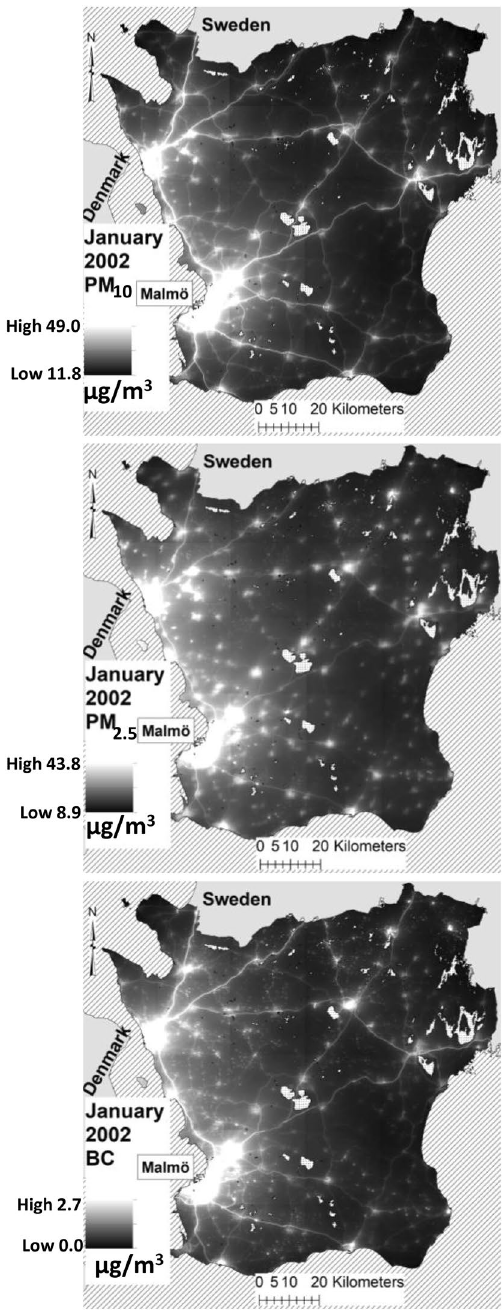
, PM and BC in Scania during Janu- 10 2.5